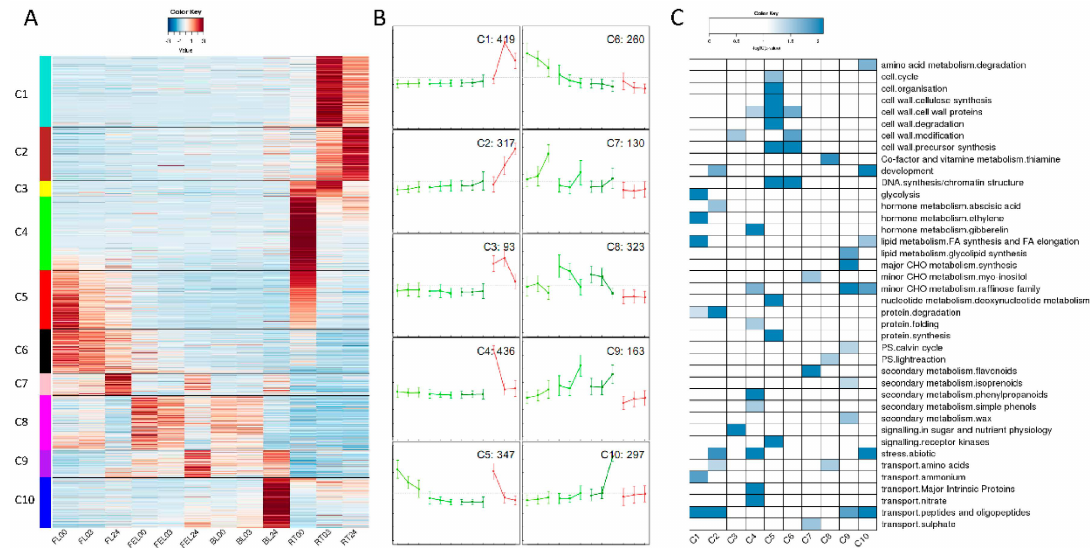
Figure 4. Gene expression patterns across leaf and root samples. ( A ) Heatmap of 2785 DEGs that were grouped into ten clusters by K-mean method; ( B ) Expression patterns of ten clusters in ( A ). The samples (from left to right ) are the same as those presented in ( A ). Error bars represent standard deviation, and DEG numbers are shown in the upper right corner; ( C ) Functional category enrichment of each cluster in ( A